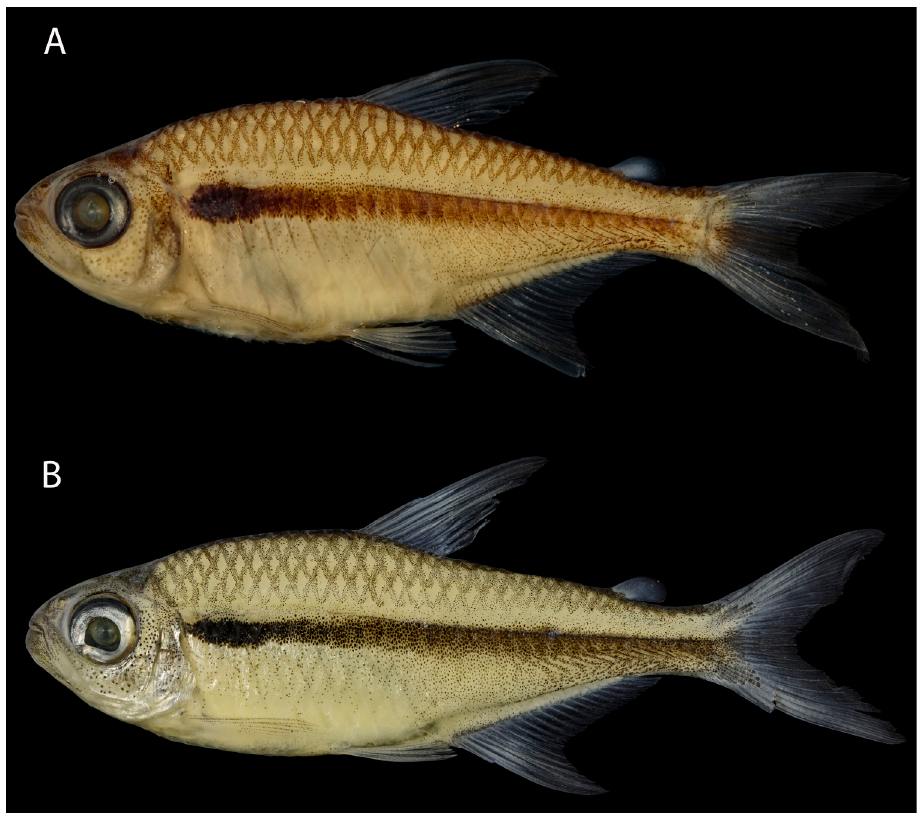
FIGURE 1 | Hyphessobrycon cantoi . A. ZUEC 17228, holotype, 30.2 mm SL, female, Brazil, Pará, Santarém, Alter do Chão, stream tributary of Lago Verde, rio Tapajós basin. B. ZUEC 14597, paratype, 32.1 mm